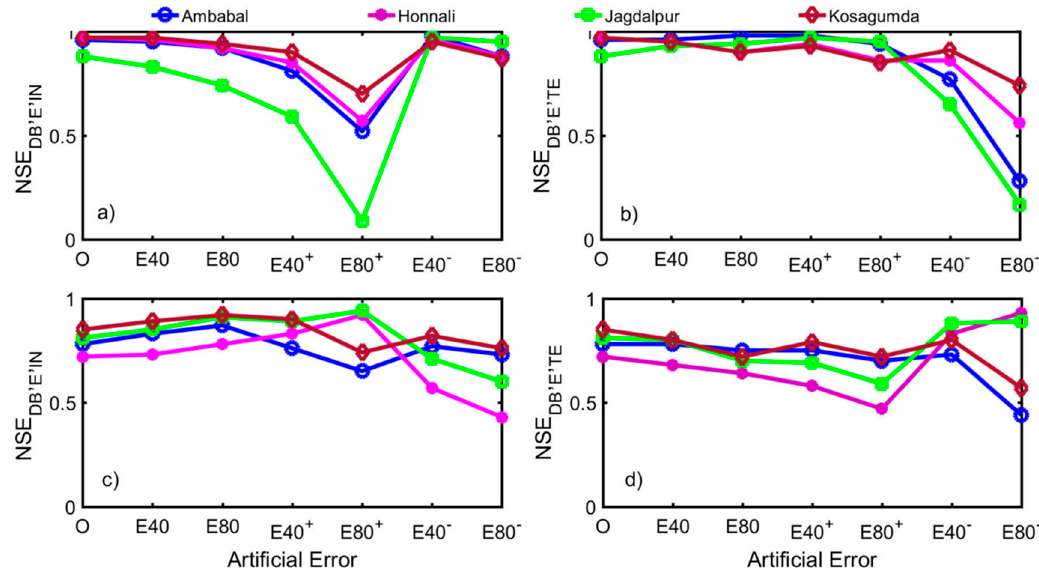
Figure 7. Model performance is sensitive to observational errors for four sample catchments. ( a , b ) show DB model performance due to error ( E ) in input data ( NSE DB , E , IN ) and test data ( NSE DB , E , TE ). Similarly, ( c , d ) show how NSE IDW , E , IN and NSE IDW , E , TE are sensitive to error in observed test data (discharge time series). For each experiment, six error distributions were considered ( E 40, E 80, E 40 + , E 80 + , E 40 − , and E 80 − ). Each sample basin reacted to error distributions uniquely. Other basins of the study region displayed similar behaviour. Although errors in input data can negatively impact model performance, it should be noted that the two models used entirely di ff erent input datasets, and thus the choice of a particular model may be decided based on the quality of the available datasets. The figure also shows that a low NSE may not always imply poor model performance.